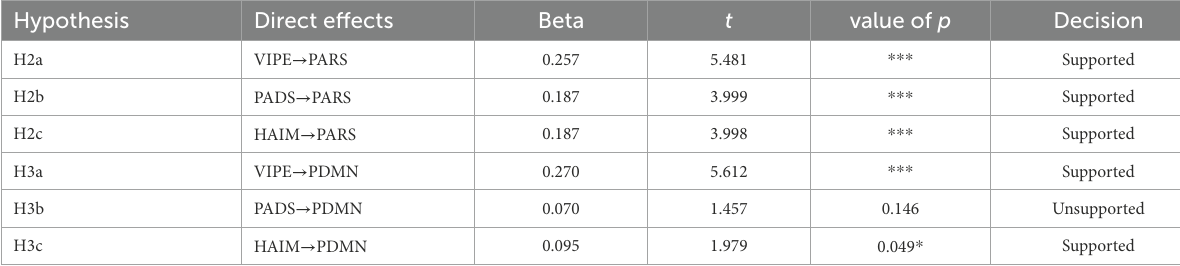
TABLE 7 Test of direct